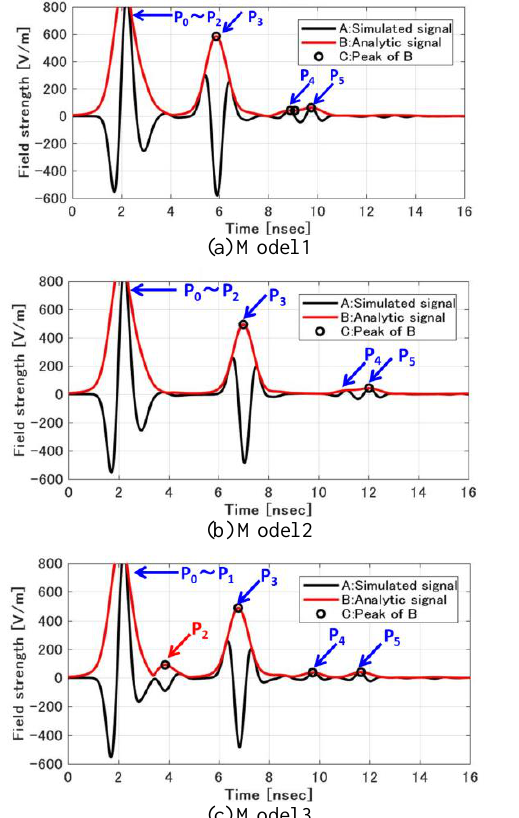
Figure 8. Simulation